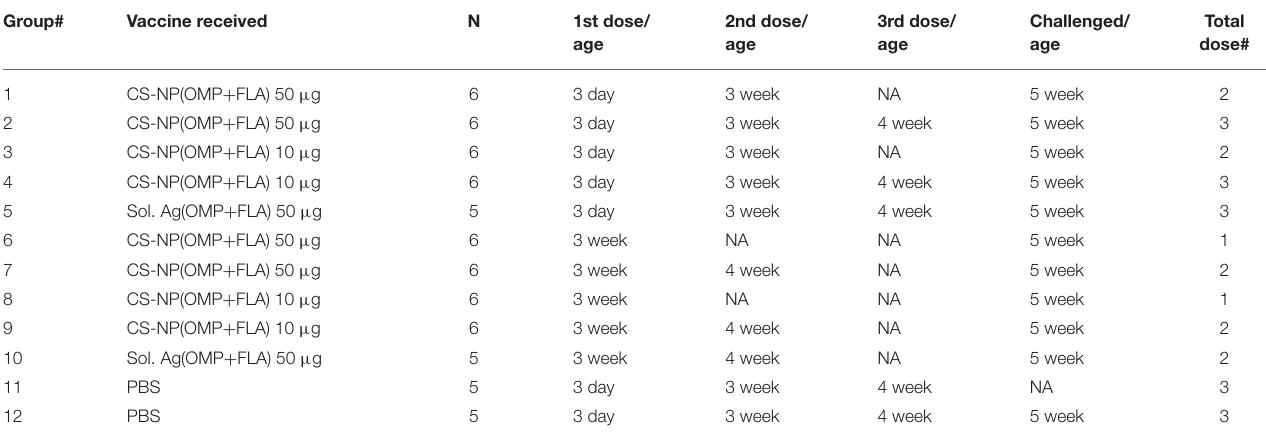
TABLE 1 | Experimental animal